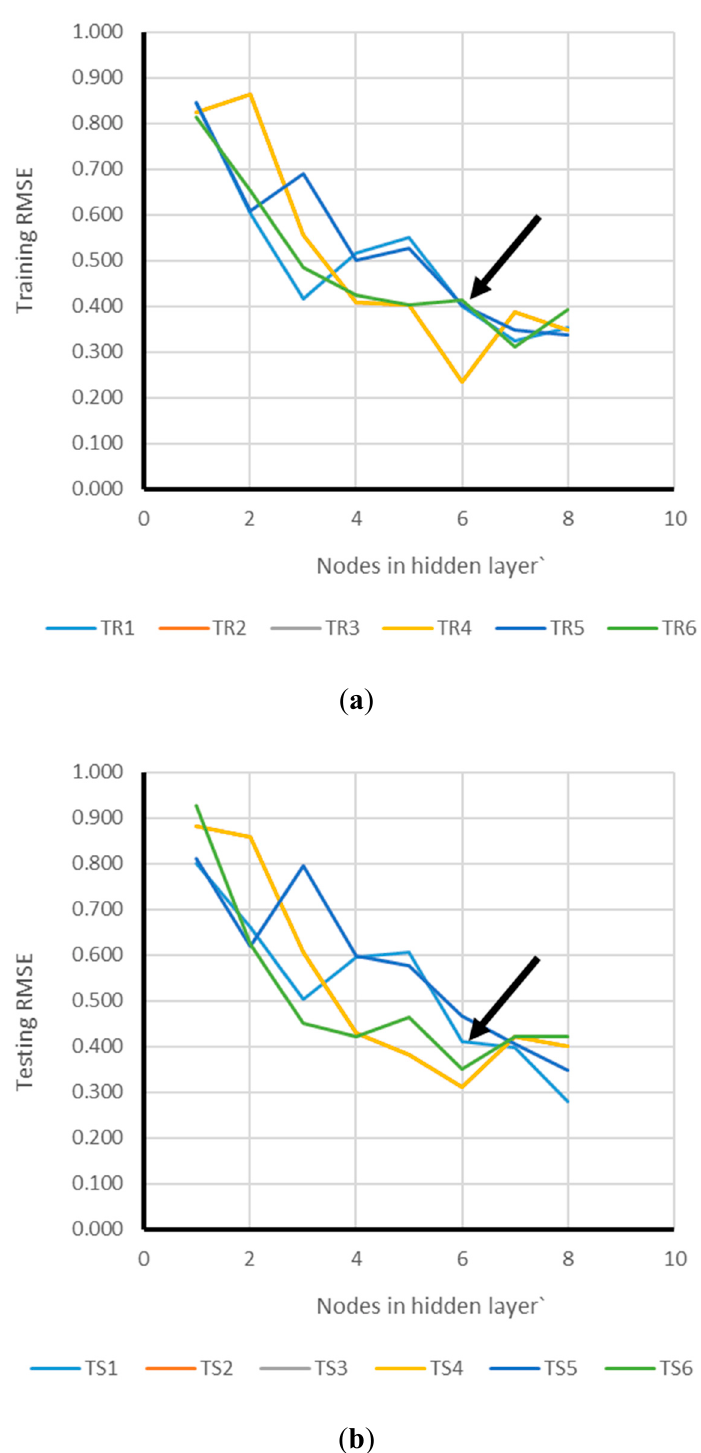
Figure 8. The RMSE sensitivity evaluation of various suggested ANNs on neurons number in each hidden layer. ( a ) RMSE performance for the training dataset, ( b ) RMSE performance for the testing